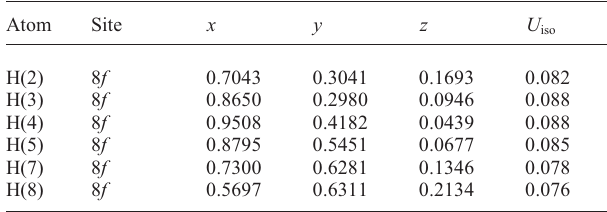
Table 2. Atomic coordinates and displacement parameters (in Å 2 )